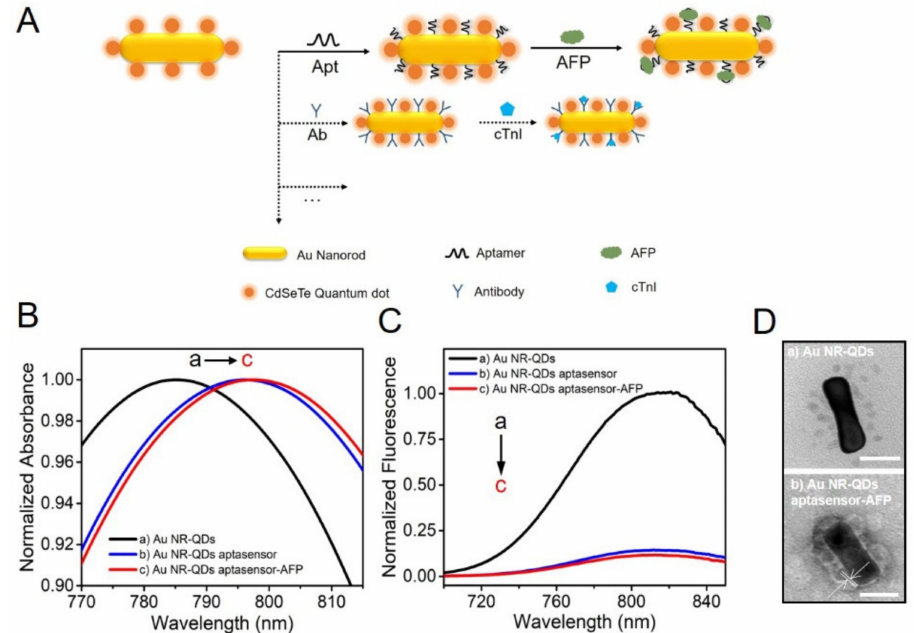
Figure 3. The Au NR-QDs apta-sensor for alpha fetal protein (AFP) detection. ( A ) Schematics for the construction of Au NR-QDs nano-sensors by modifying Au NR-QDs with di ff erent types of sensing layers such as aptamers and antibodies. ( B ) Normalized UV-vis absorption spectra and ( C ) normalized fluorescence spectra of Au NR-QDs (a), Au NR-QDs apta-sensor (b), and Au NR-QDs apta-sensor-AFP nanocomplex (c), where the maximum fluorescence intensity of Au NR-QDs was regarded as 1.00. ( D ) TEM images of Au NR-QDs (a) and Au NR-QDs apta-sensor-AFP nanocomplex (b), respectively. Scale bars are 25